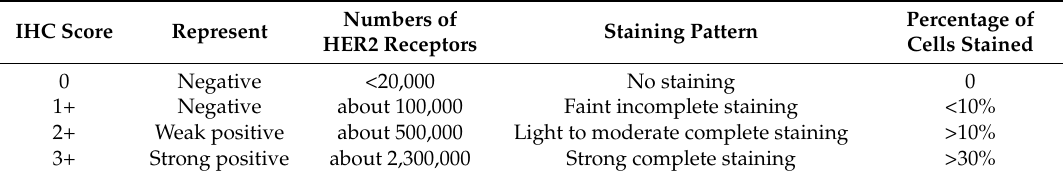
Table 1. Scoring criteria for immunohistochemistry (IHC) results [51].